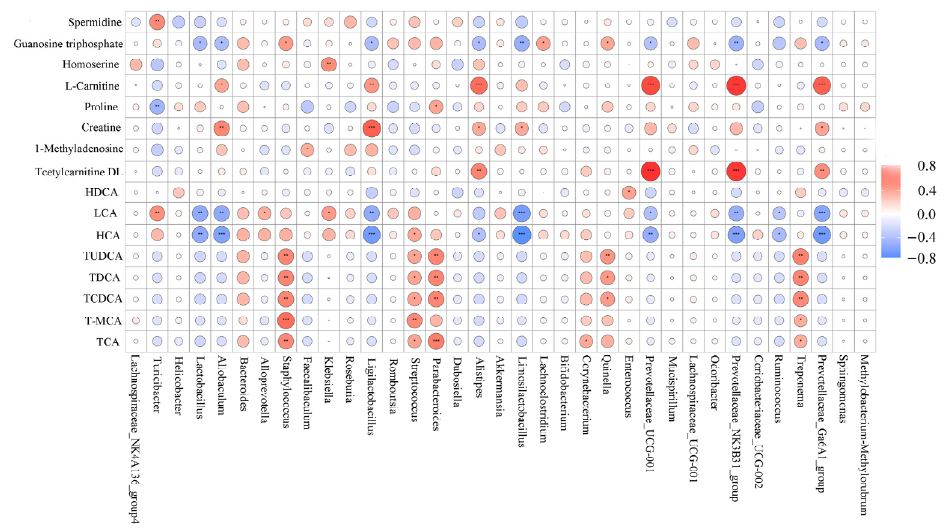
Figure 11. Spearman analysis between bacterial genera and microbial metabolites. * p < 0.05, ** p < 0.01 and *** p < 0.001.